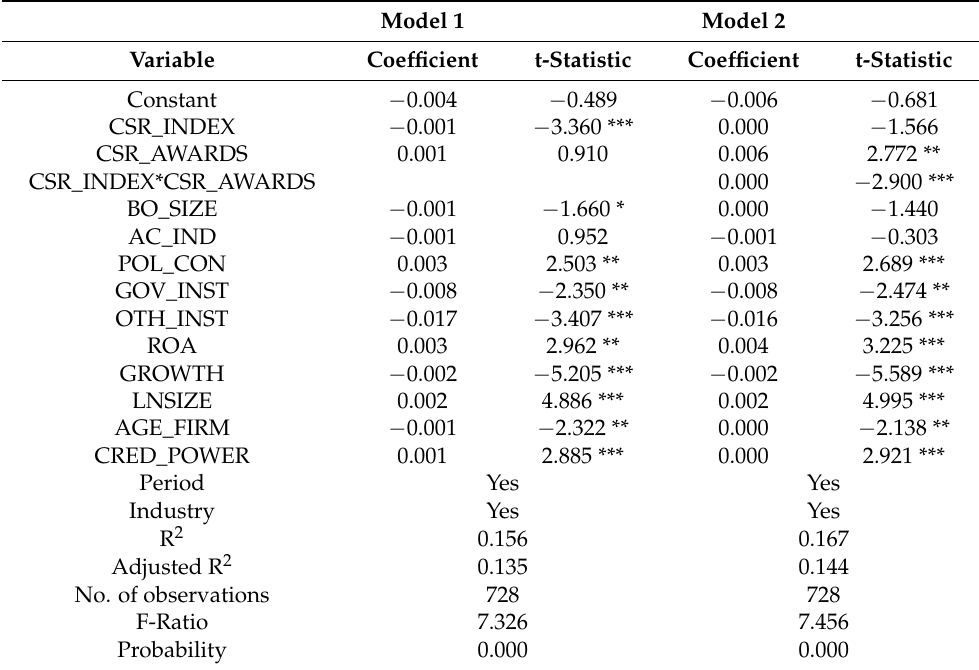
Table 4. Regression results of Model 1 using COD_INT as a dependent variable, and Model 2 uses the moderator effect of CSR_AWARDS and